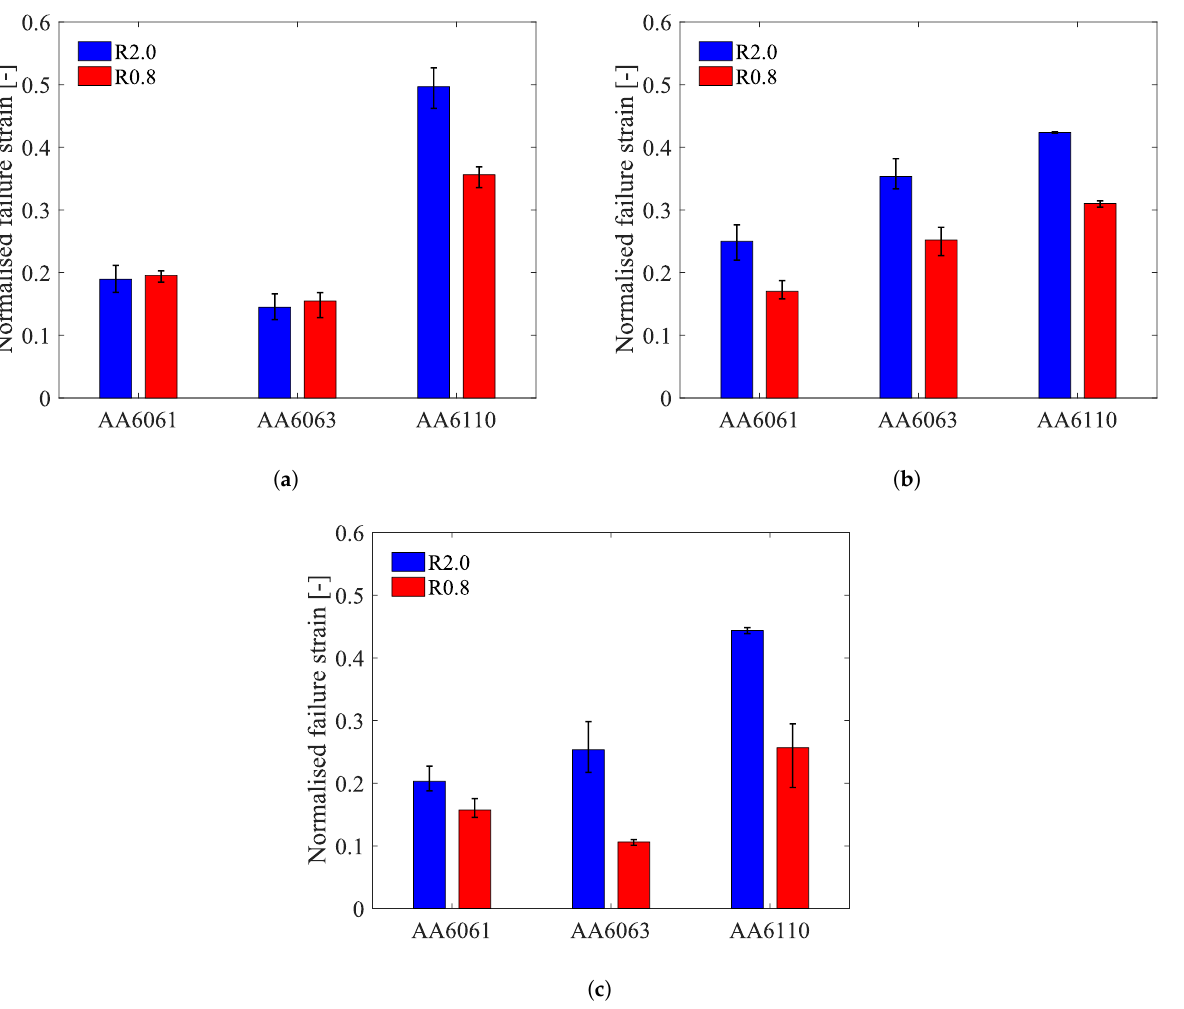
Figure 8. Notch sensitivity in terms of normalized failure strain of an alloy as function of specimen type, shown for the ( a ) 0 ◦ direction, ( b ) 45 ◦ direction and ( c ) 90 ◦ direction. The normalized failure strain is defined as the failure strain of the notched specimen (R2.0 or R0.8) divided by the failure strain of the smooth specimen. Average values of the normalized failure strain for all repeat tests are represented by the bars, while the scatter bars indicate the data